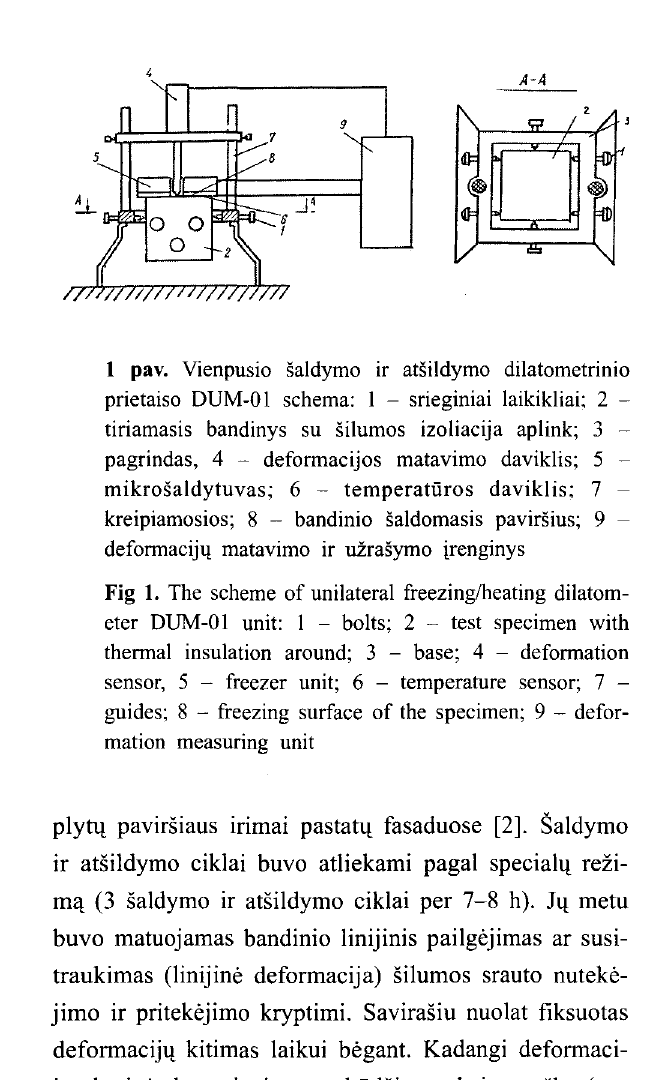
Fig 1. The scheme of unilateral freezing/heating dilatom eter DUM-01 unit: I - bolts; 2 - test specimen with thermal insulation around; 3 - base; 4 -